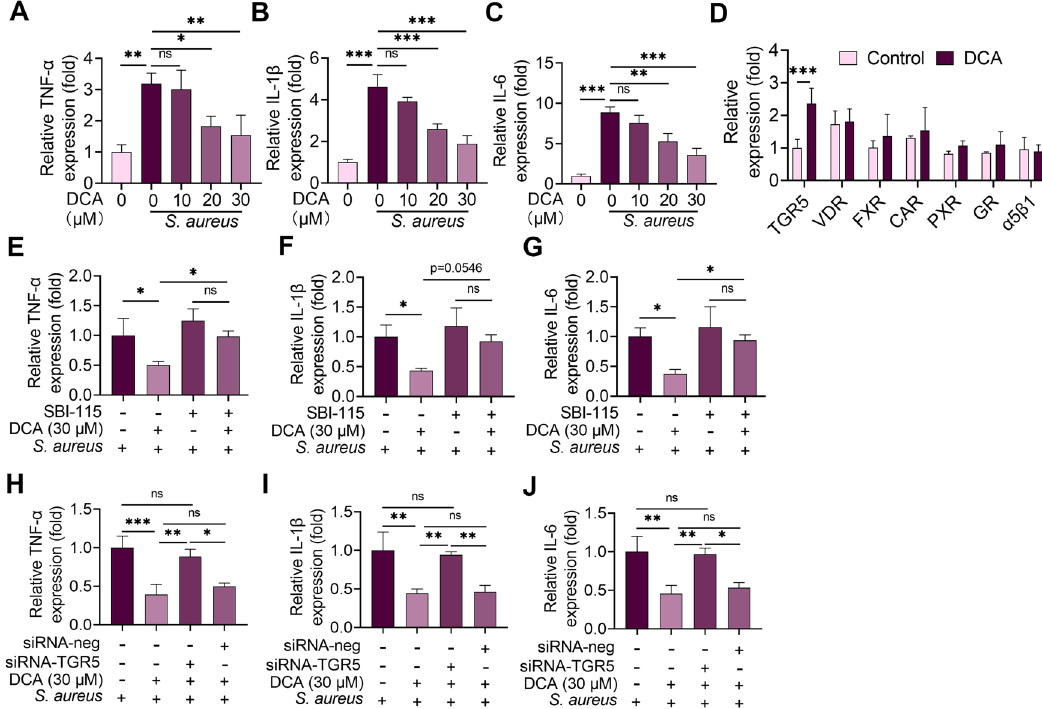
Fig. 3 DCA alleviates S. aureus -induced in fl ammation in MMECs by activating TGR5. Cells were pretreated with DCA (10, 20 and 30 μ M) for 2 h followed by S. aureus treatment for next 24 h, and the relative mRNA levels of proin fl ammatory TNF- α ( A ), IL-1 β ( B ), and IL-6 ( C ) from the indicated group were detected by qPCR. D Cells were treated with DCA (30 μ M) for 24 h and the relative mRNA levels of TGR5, VDR, FXR, CAR, PXR, GR and α 5 β 1 were determined using qPCR. Cells were pre-treated with SBI-115 for 2 h and then treated with DCA (30 μ M) for an additional 2 h followed by S. aureus treatment for the next 24 h. Relative mRNA levels of proin fl ammatory TNF- α ( E ), IL-1 β ( F ), and IL-6 ( G ) from the different treatment groups were detected by qPCR. H – J Cells were pretreated with siRNA-TGR5 or siRNA-neg for 48 h followed by DCA (30 μ M) and S. aureus treatment as mentioned above, and the relative mRNA levels were detected by qPCR. Data are expressed as the means ± SD ( A – J ) and one-way ANOVA followed by Tukey ’ s test ( A – C and E – J ) and Student ’ s t -test was performed ( D ). * p < 0.05, ** p < 0.01, *** p < 0.001 indicate signi fi cance. ns no signi fi